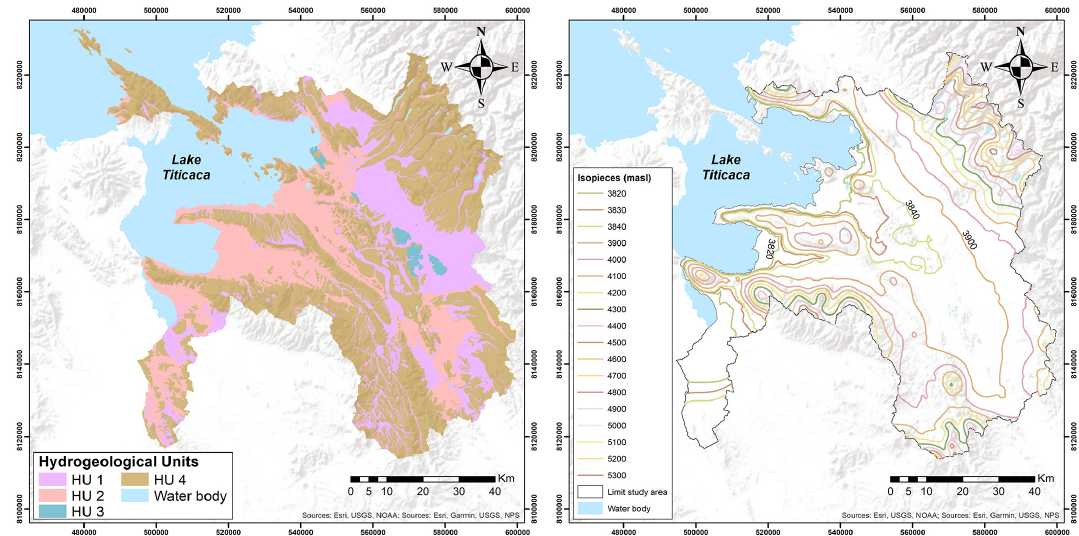
Figure 2. Piezometric map (a) obtained using data compiled (scale 1 : 10000, basemap source: ArcGIS, ESRI). Transmissivity map of the hydrogeological units interpreted according with Alanoca (2018) (b)